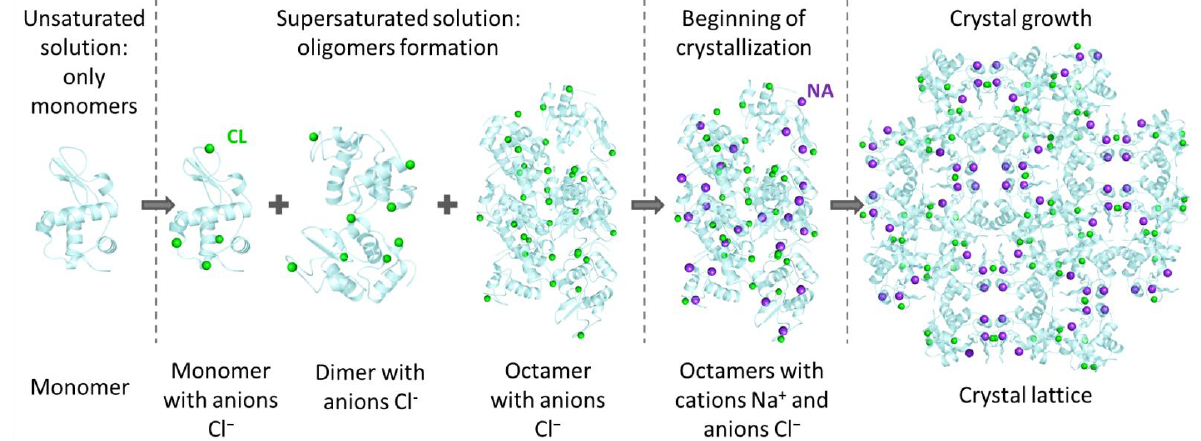
Figure 3. The model of initial steps before protein crystal growth: unsaturated monomer solution -> oligomers formation with anions (all found in crystal structure or some of them) association to monomers and oligomers -> cations incorporation in the oligomers leading to crystal formation.